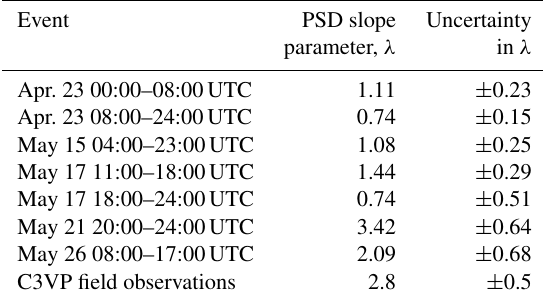
Table 1. MASC-observed slope parameters for exponential particle size distributions for the Barrow snow events. The C3VP observa- tions were derived from field observations with similar snow rates as the Barrow storms (Wood et al.,